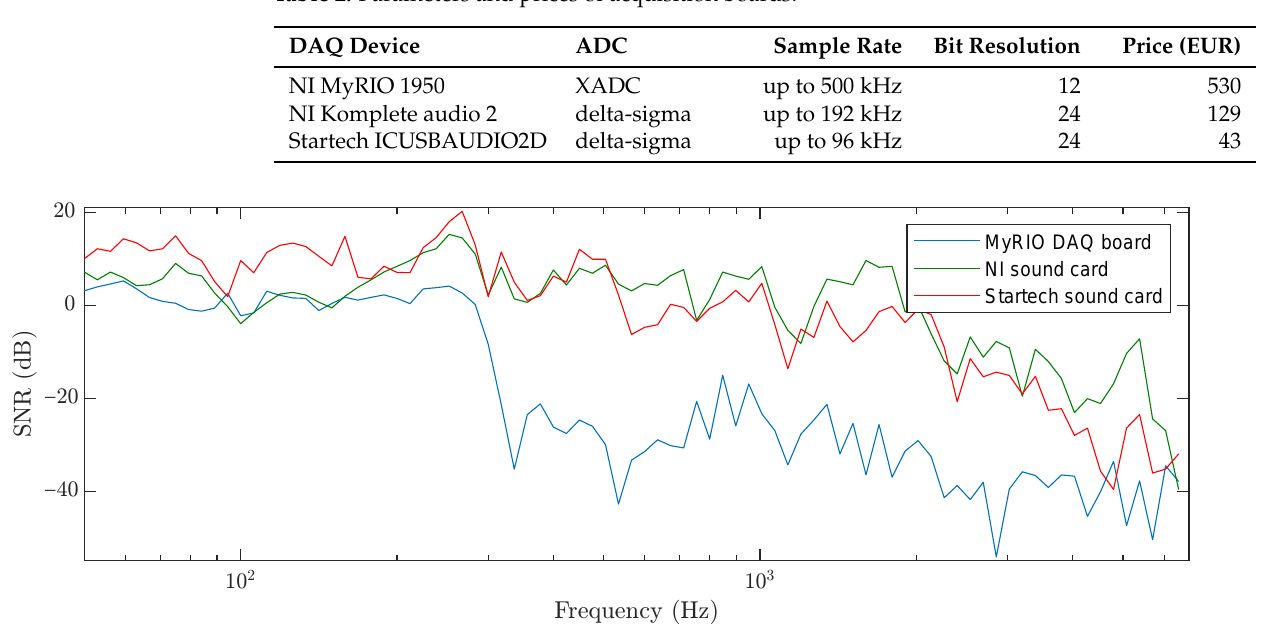
Table 2. Parameters and prices of acquisition boards.